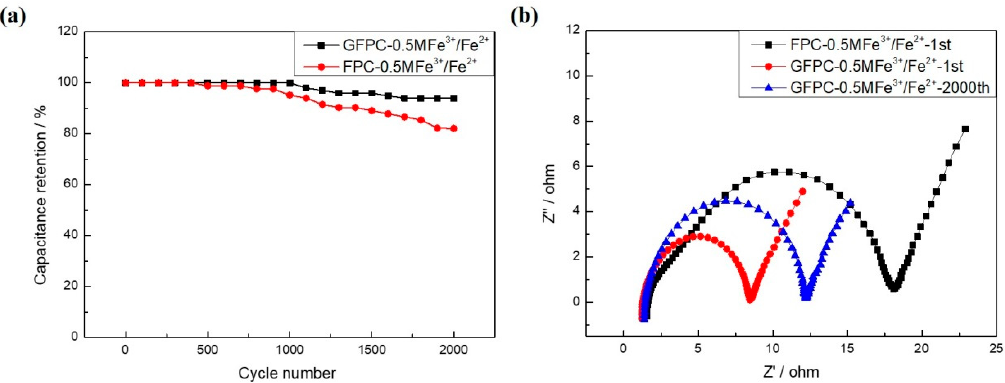
Figure 8. ( a ) Cycling performance of GFPC in a 1 M H 2 SO 4 + 0.5 M Fe 3 + / Fe 2 + electrolyte of 10 A · g − 1 , Figure 8 ( a ) Cycling performance of GFPC in a 1 M H 2 SO 4 + 0.5 M Fe 3+ /Fe 2+ electrolyte of 10 A ∙ g − 1 , ( b )